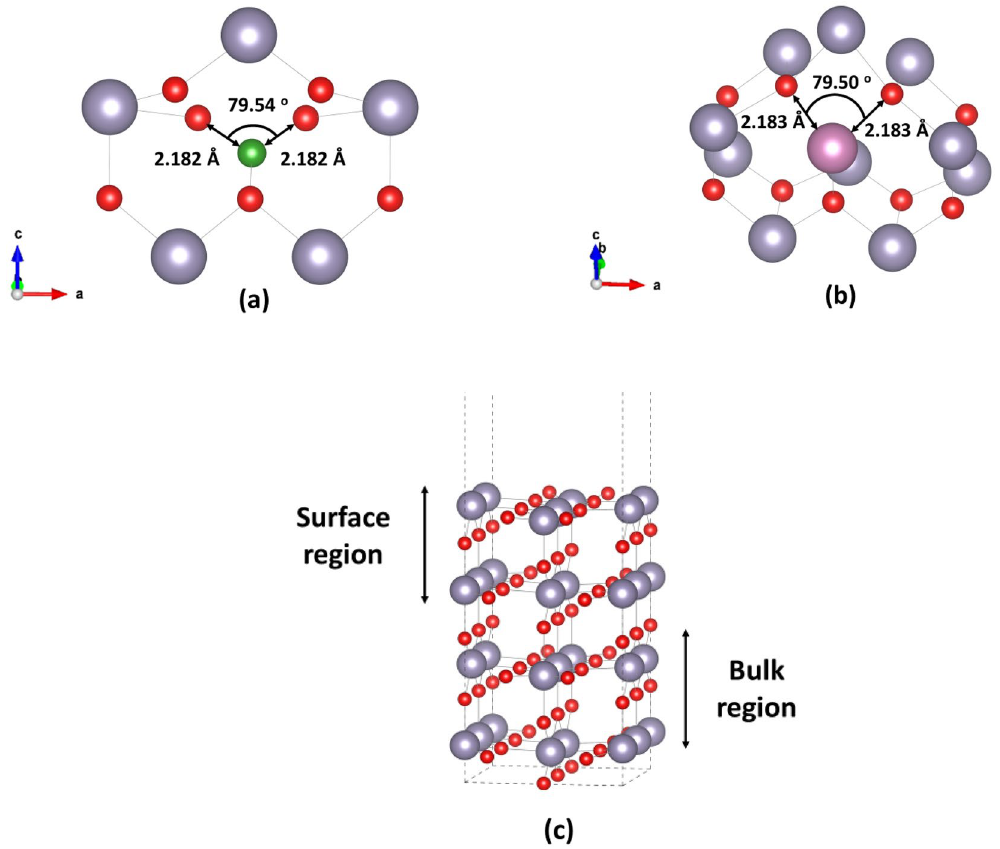
Figure 6. The structures of ( a ) boron doped (110) SnO 2 surface, ( b ) indium doped (110) SnO 2 surface and ( c ) the (110) surface supercell.